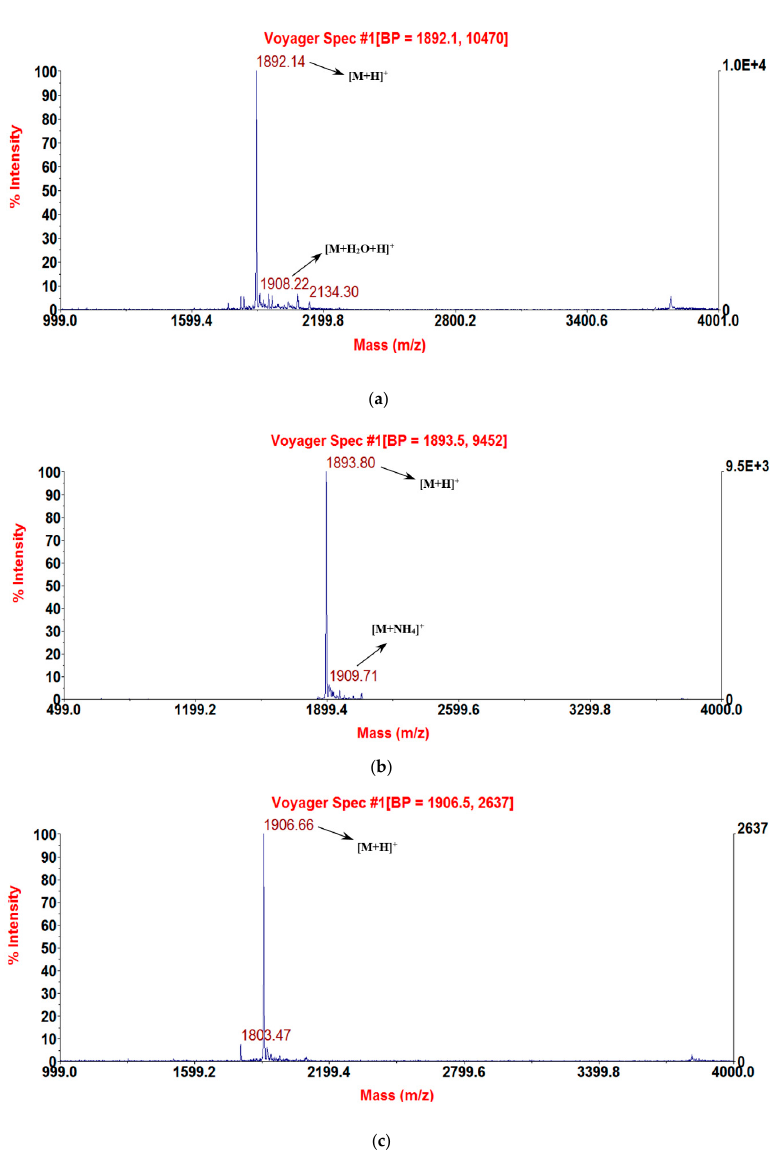
Figure 3. MALDI-TOF MS spectra of the three purified synthetic peptides: ( a ) RNF (1892.69 [M+H] + ); ( b ) RNF1 (1893.8 [M+H] + ); and ( c ) RNF3L (1906.66 [M+H] + ).